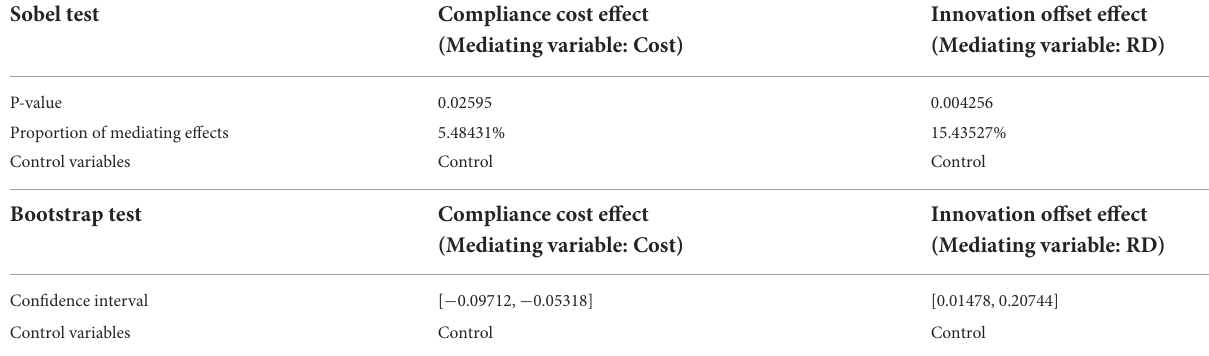
TABLE 11 Results of Sobel test and bootstrap test. Sobel